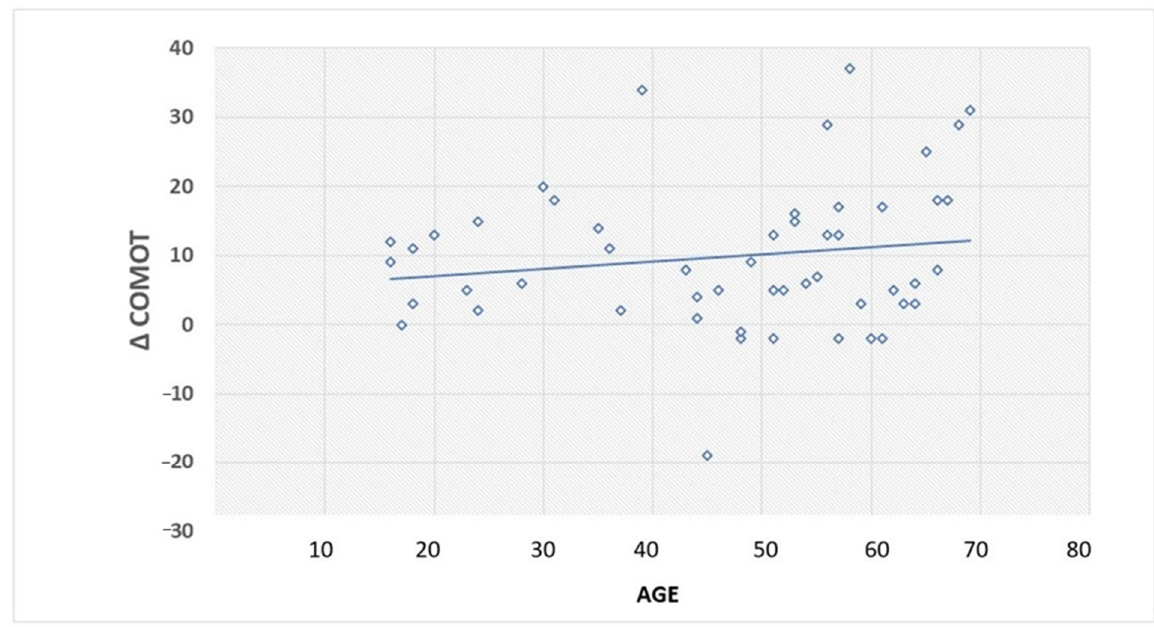
Figure 3. Correlation between age and ∆ -COMOT.